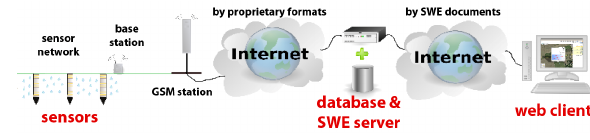
Figure 3. Overall architecture and data flow.